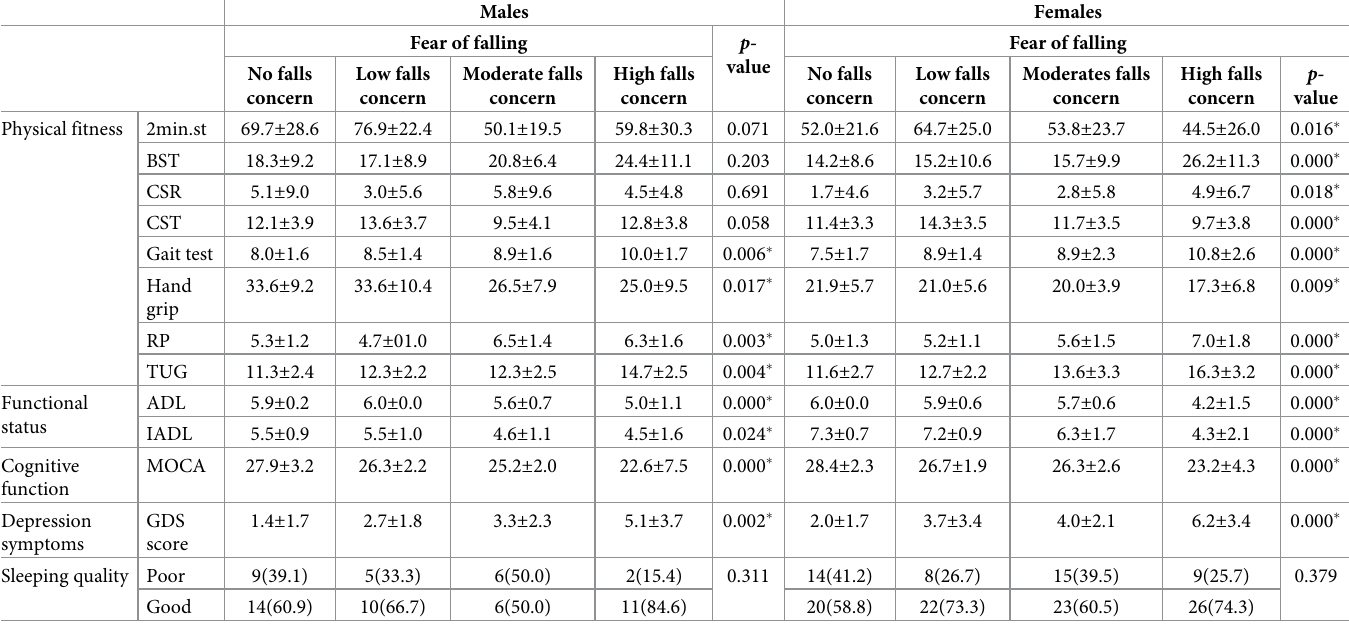
Table 5. Physical and cognitive function characteristics according to fear of